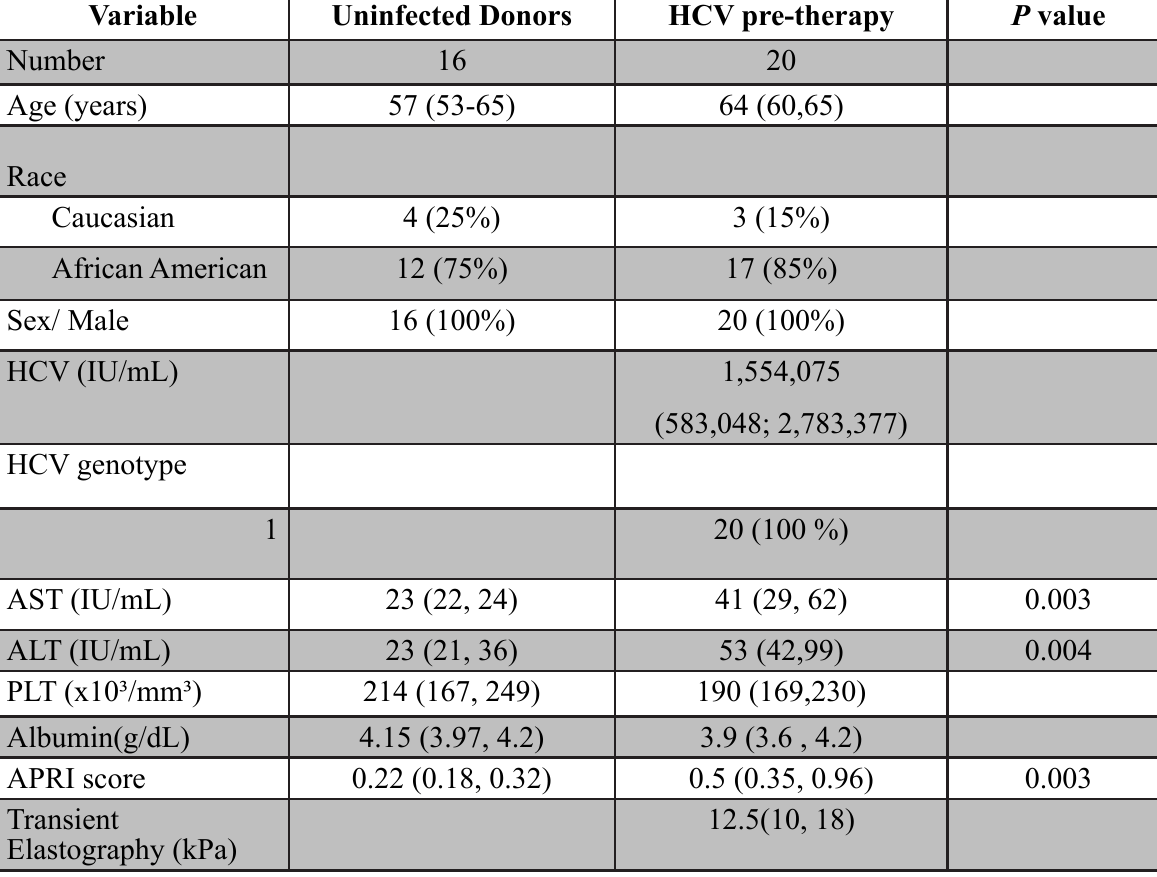
Table 1. Study Participant Clinical